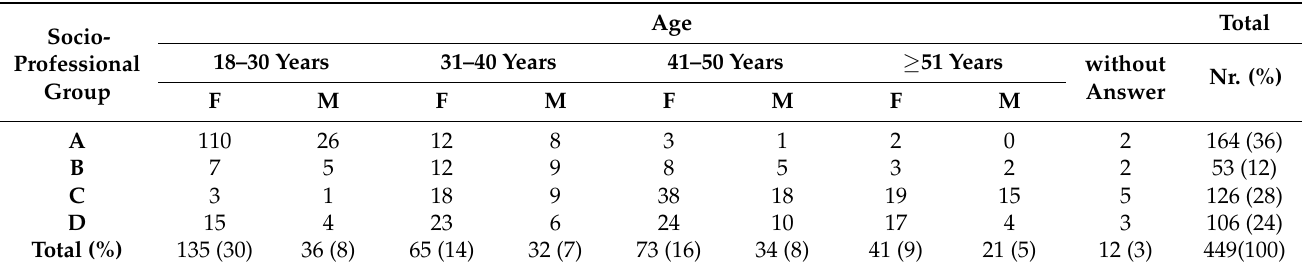
Table 1. Profile of the population of survey respondents by age, gender, and socio-professional group.